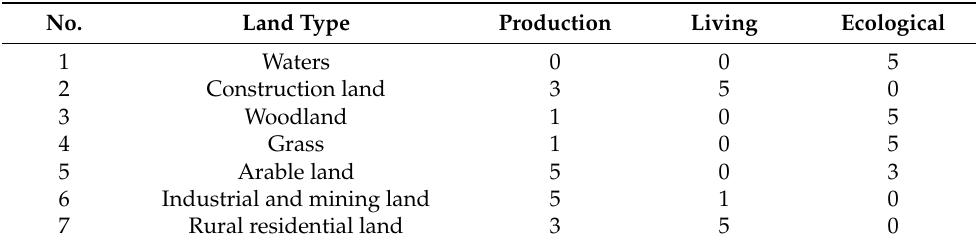
Table 2. Marking criteria for PLES function evaluation for the different land types. No. Land Type Production